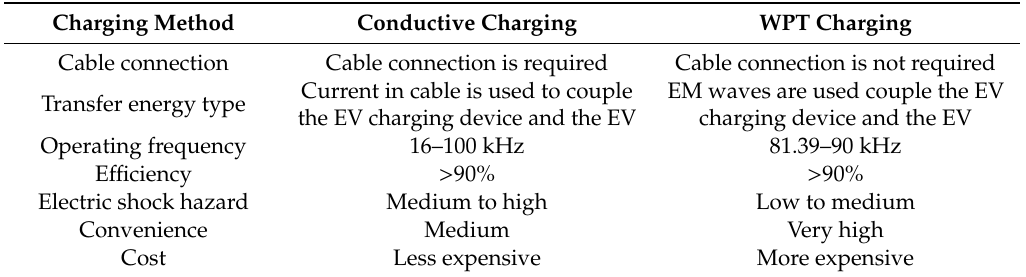
Table 1. Di ff erences between conductive charging and wireless power transfer (WPT) charging